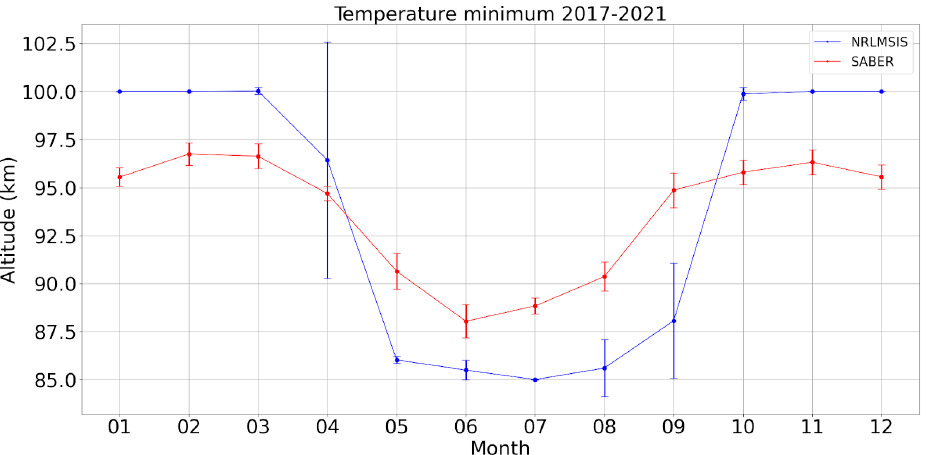
Figure 5. Monthly average altitude and average statistical deviations of temperature minima from 2017 to 2021 from SABER (red) and NRLMSIS model (blue) data.